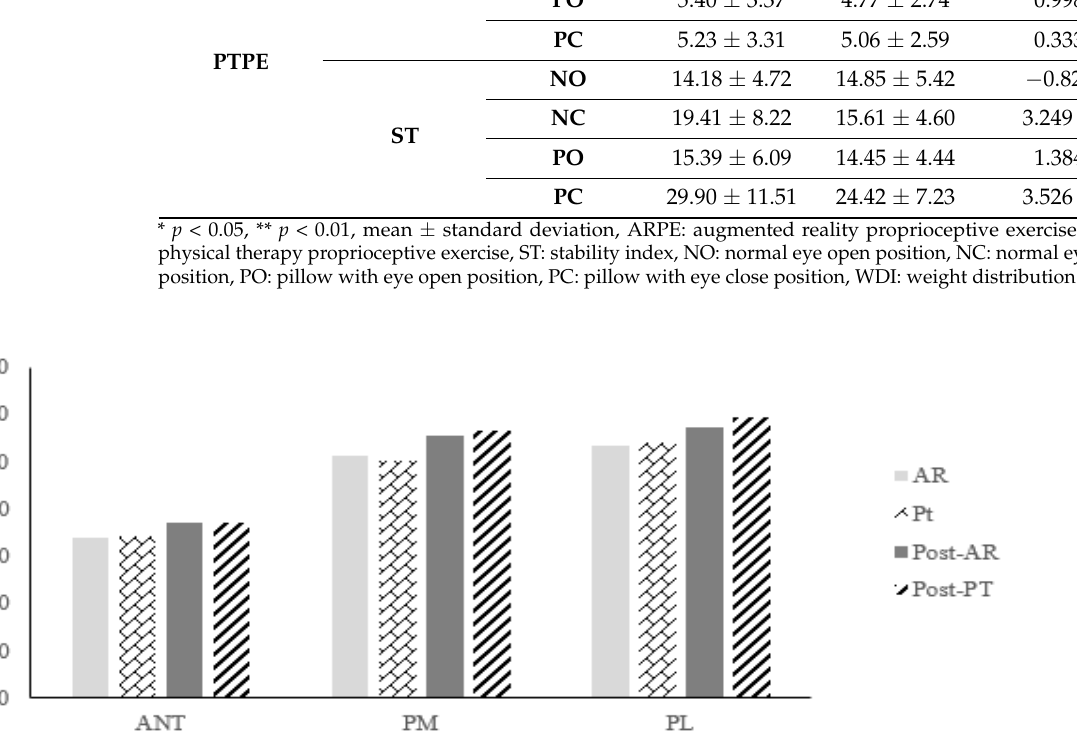
Table 7. Comparison of dynamic balance between groups after intervention.